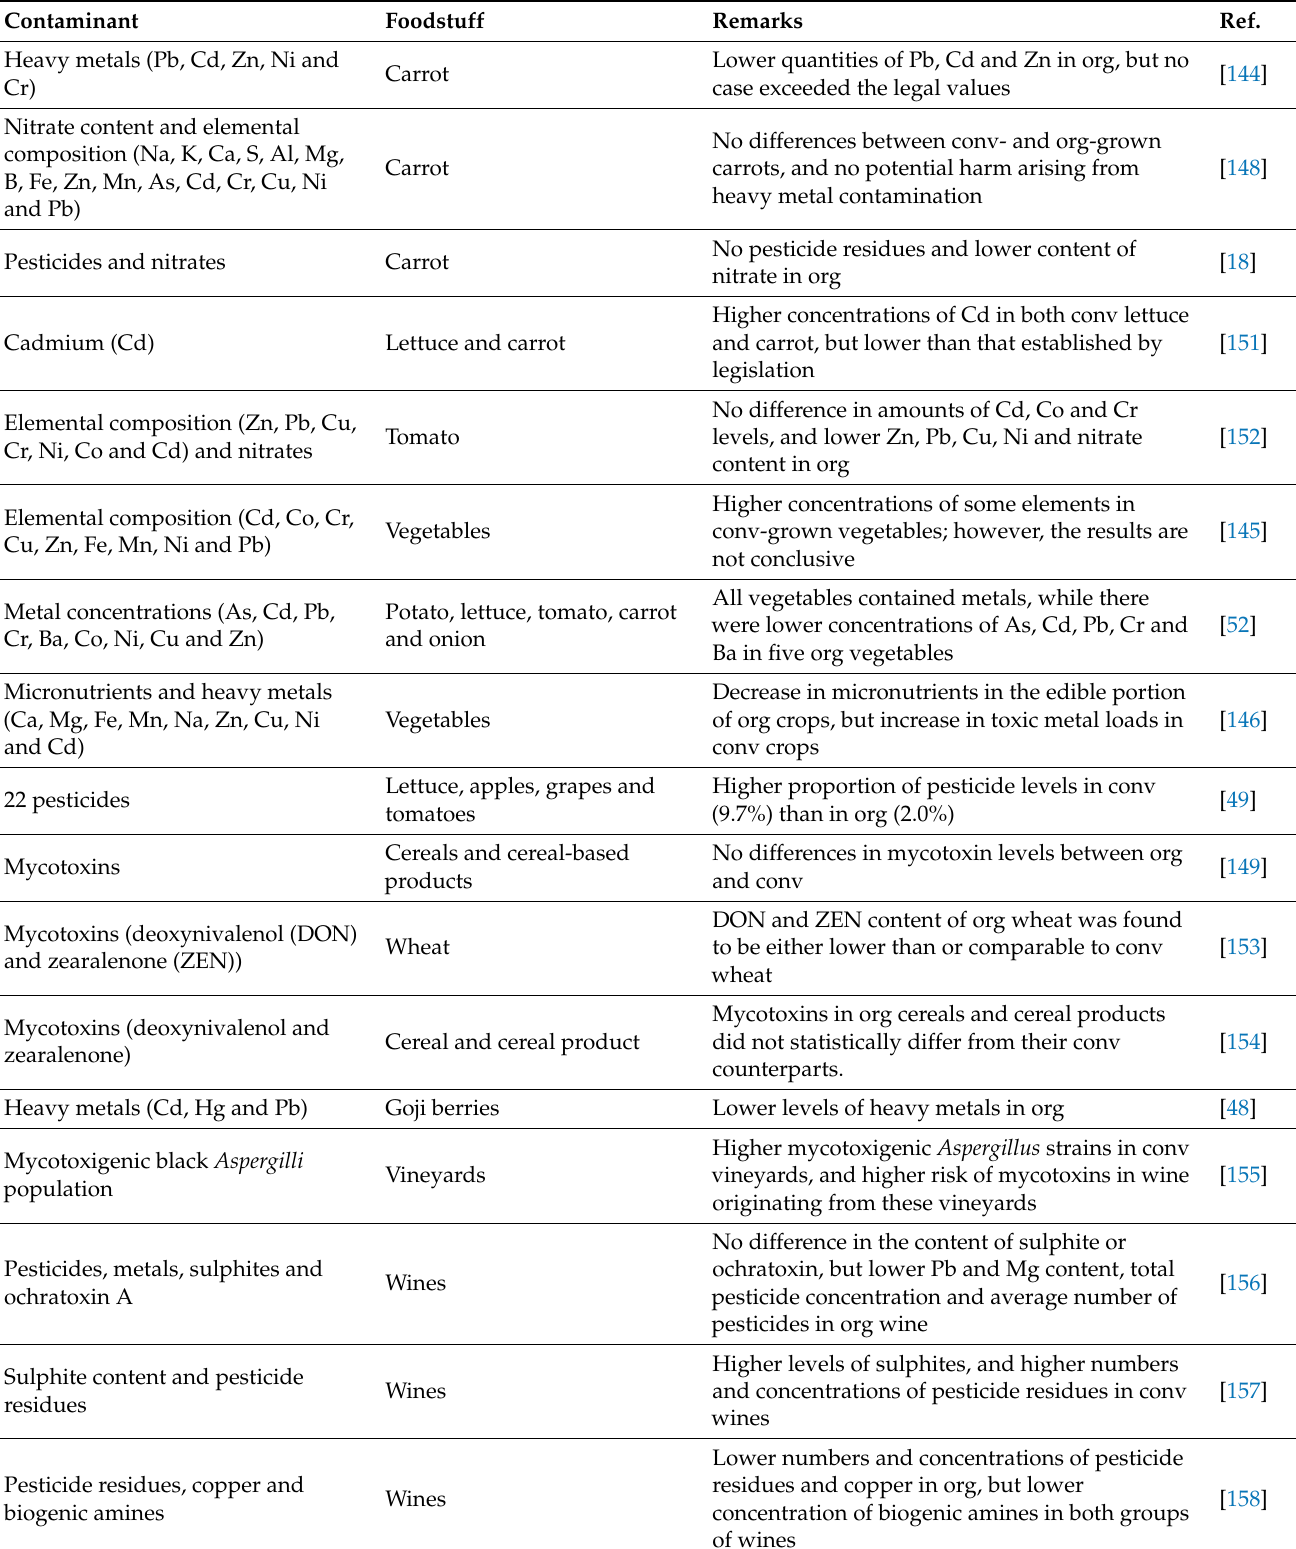
Table 2. Summary of some studies on the occurrence of contaminants in organic and conventional